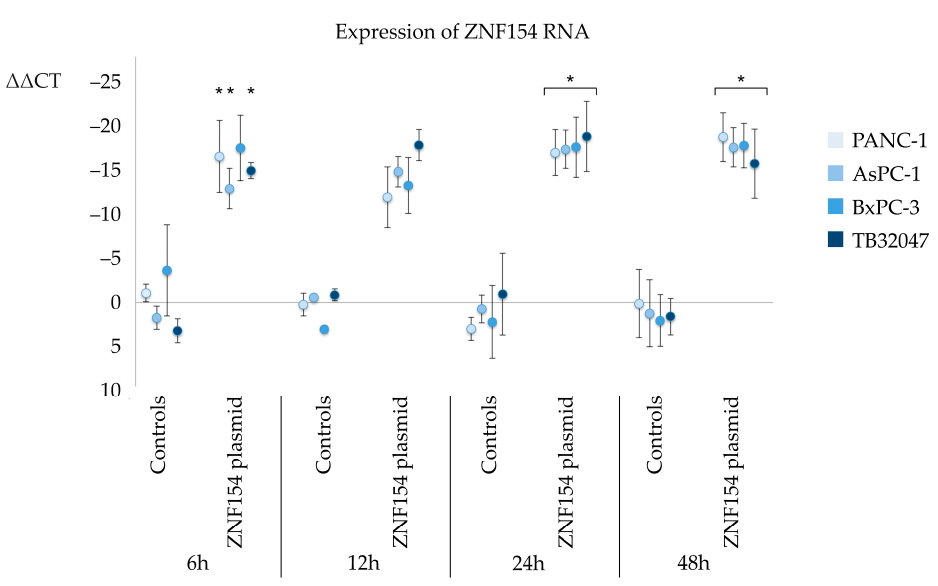
Figure 4. Relative expression of ZNF154 following transient transfections detected by q PCR (* = p < 0.05 using student (cid:48) s t -test; ∆∆ Ct in relation to empty controls; error bars indicate standard